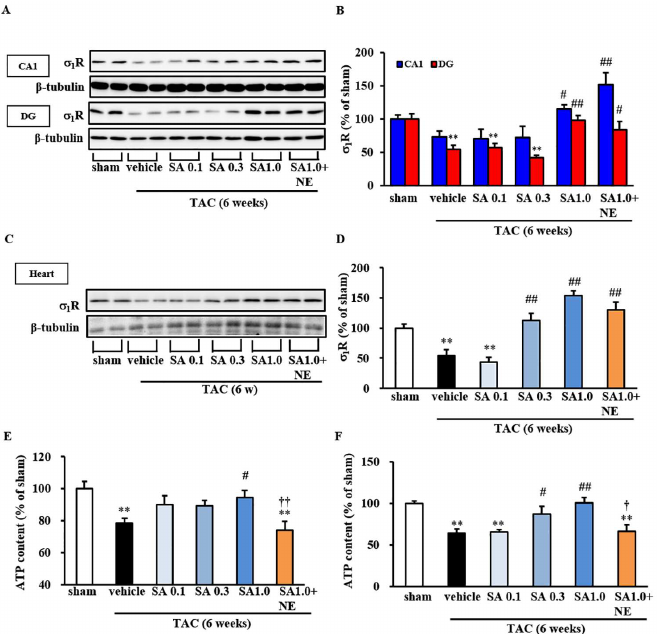
Fig 2. Effect of SA4503 treatment on hippocampal σ 1 R expression and ATP content. A: Western blot analysisof σ 1 R and β -tubulin (as a loadingcontrol) proteins in the CA1 region and dentate gyrus (DG) of sham and TAC-mice. Immunoblotting with anti- β -tubulin antibody indicatesequal protein loading. B: Densitometric quantification of σ 1 R immunoreactivity. F (5, 32) = 7.128, P < 0.01 (CA1); F (5, 26) = 9.868, P < 0.01 (DG). C: Western analysis of σ 1 R and β -tubulin(as a loadingcontrol) proteins in the LV of sham and TAC-mice with or without drug treatment. Immunoblotting with anti- β -tubulin antibody indicatesequal protein loading.D: Densitometric quantification of σ 1 R immunoreactivity. F (5, 47) = 20.484, P < 0.01. In B and D, ** , P < 0.01 versus the sham group; #, P < 0.05 and ##, P < 0.01 versus the TAC/vehicle-treatedgroup E: Measurement of cellular ATP content in hippocampal tissue of TAC mice 6 weeks after surgery with or without drug treatment during the last 4 weeks (n = 6). F (5, 47) = 6.284, P < 0.01. F: Measurement of cellular ATP content in the LV of TAC mice with or without drug treatment (n = 6). F (5, 54) = 15.089, P < 0.01 (CA1). Data are expressedas percentagesof values of sham-operated animals (mean ± S.E.M.) In E amd F, ** , P < 0.01 versus the sham group; #, P < 0.05 and ##, P < 0.01 versus the TAC/vehicle-treatedgroup; † , P < 0.05 and †† , P < 0.01 versus the TAC plus SA4503 (1 mg/kg)-treated